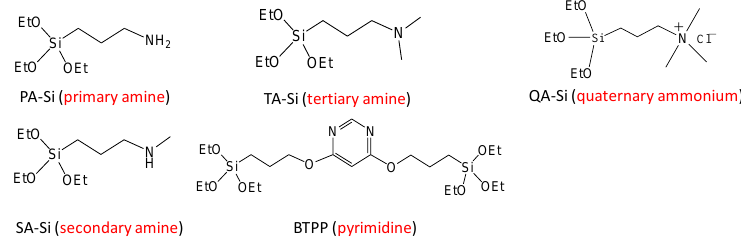
Figure 3. Chemical structures of amine-containing organosilica precursors employed in Prof. Tsuru’s group.